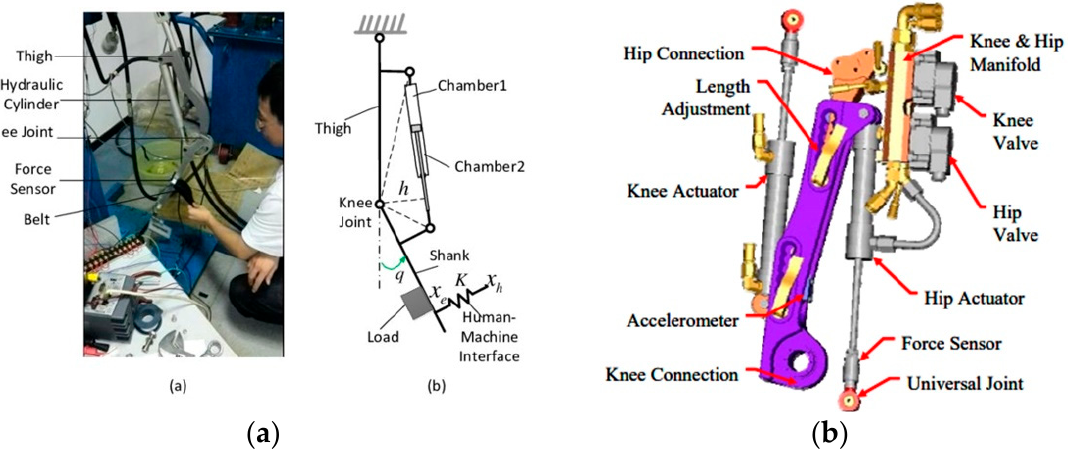
Figure 10. Knee orthosis with electrohydraulic actuator: ( a ) Chen et al., 2016 [64] y ( b ) Zoss et al., 2005 [61].